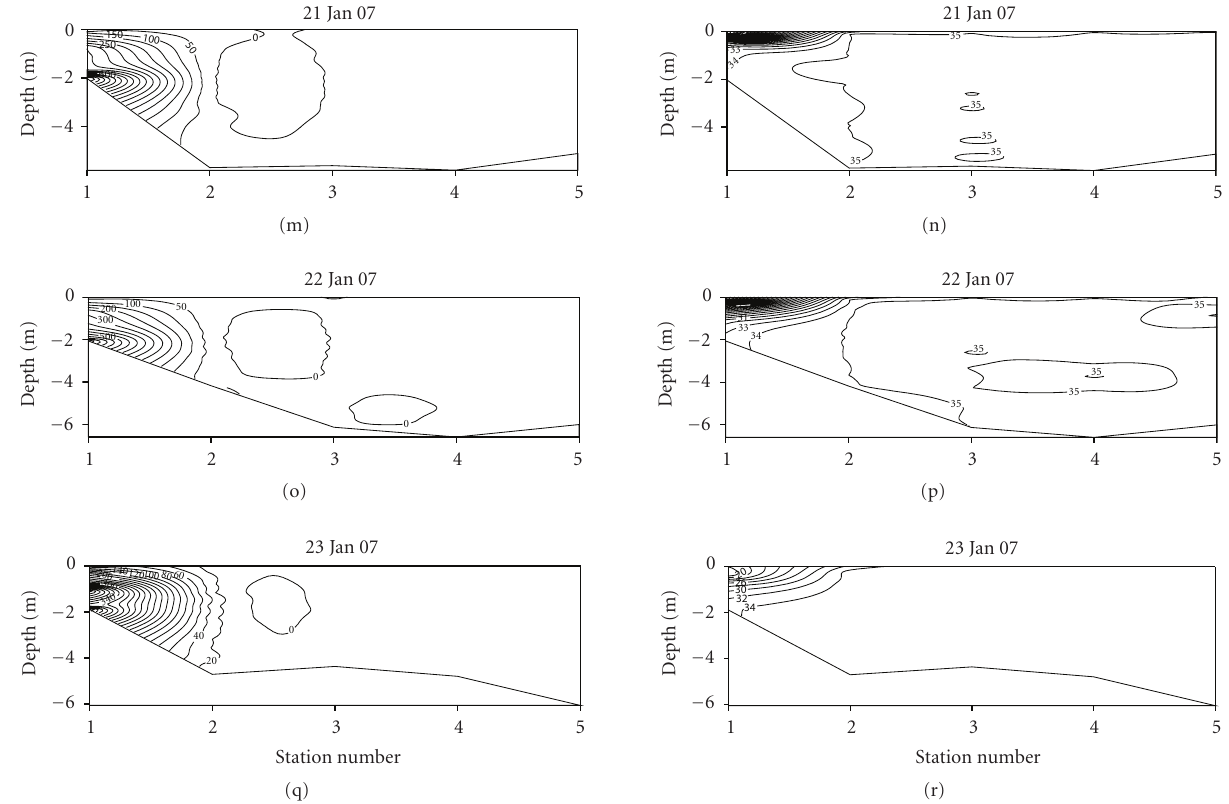
Figure 6: Snapshots at daily intervals of the two-dimensional distribution along the channel of salinity and SSC at Ngerdorch from CTD casts. The bottom line indicates the sea floor.